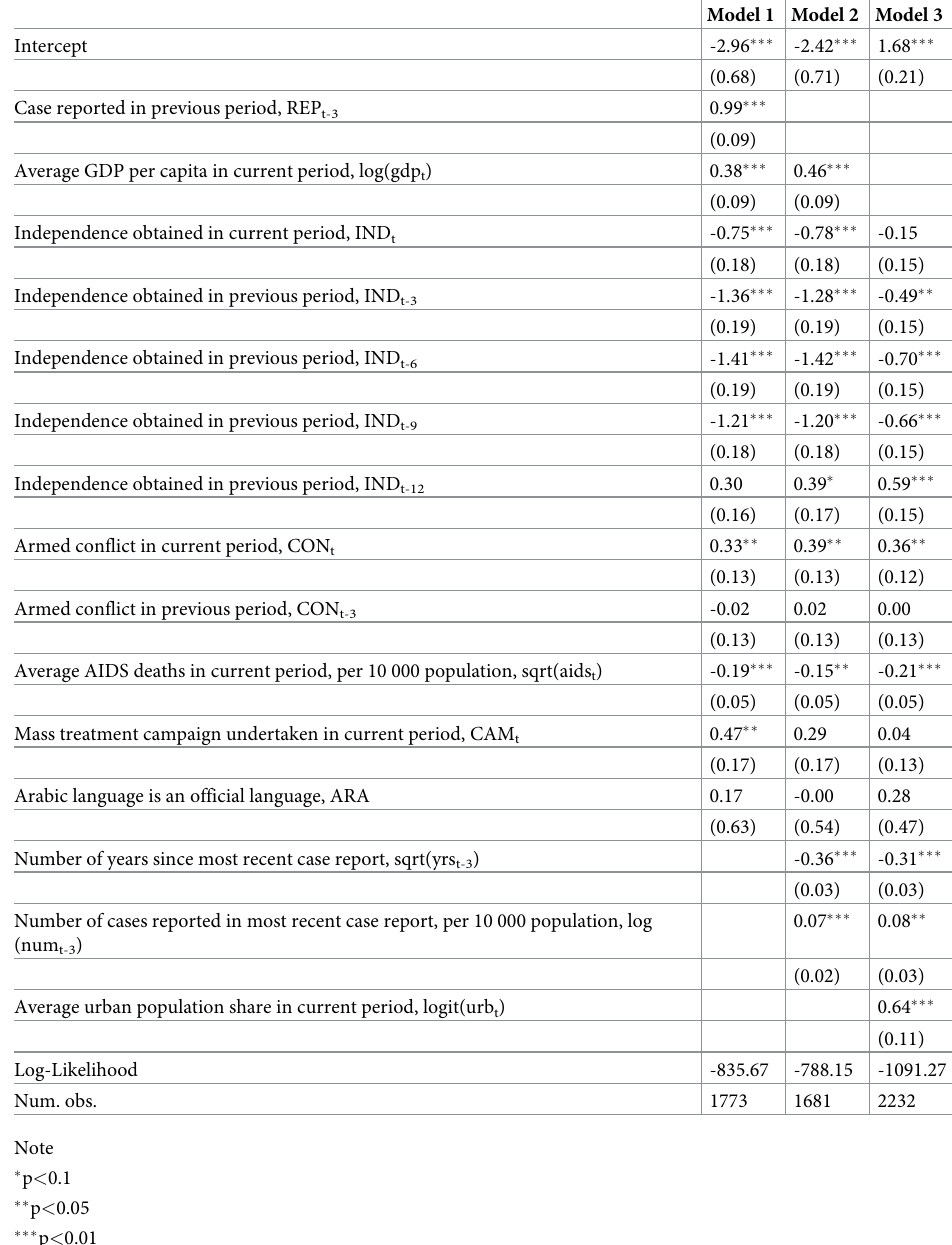
Table 4. Association between yaws case reporting and selected variables in the years before the most recent case report, all countries with a history of yaws. In the leftmost column, short variable descriptions are provided with the variable names as they appear in Eqs 1-3 –please refer to the Methods for a detailed description of each variable; the next three columns give the regression coefficients for each of the three model specifications corresponding to Eqs 1-3; the standard error of the estimate is reported in parentheses below the